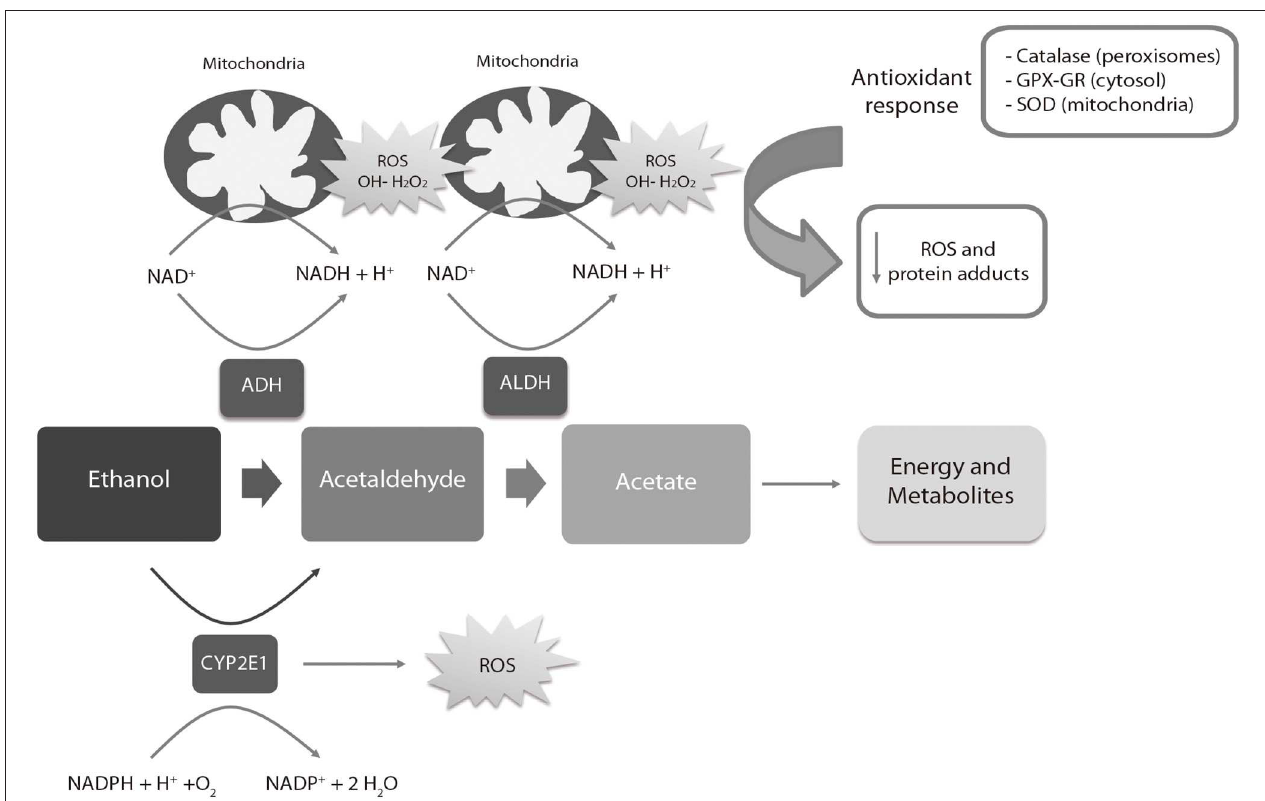
FIGURE 3 | Liver metabolic pathway of alcohol. ADH, alcohol dehydrogenase; ALDH, aldehyde dehydrogenase; ROS, reactive oxygen species; SOD, Superoxide Dismutase; GPX, Glutathione peroxidase; GR, Glutathione reductase. The ADH, ALDH enzymes and the P450 2E1 cytochrome participate in the oxidative metabolism of alcohol. The activity of the P450 2E1 cytochrome in alcohol metabolism and the re-oxidation of NADH via the electron transport chain in the mitochondria results in the formation of ROS. Catalase in peroxisomes, SOD in mitochondria and GPX-GR in cytosol are activated by an increase of oxidative stress to reduce the levels of ROS. High amounts of ROS lead to a down-regulation (negative feedback) of the antioxidant